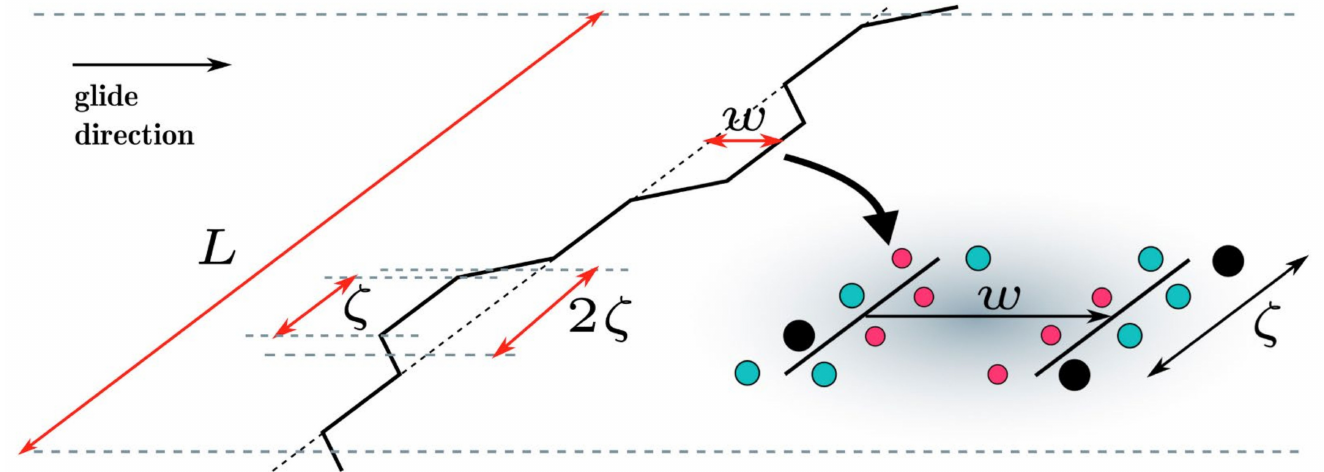
Figure 3. Schematic diagram showing low-energy arrangement of the dislocation gliding over random field of solutes. Adapted from